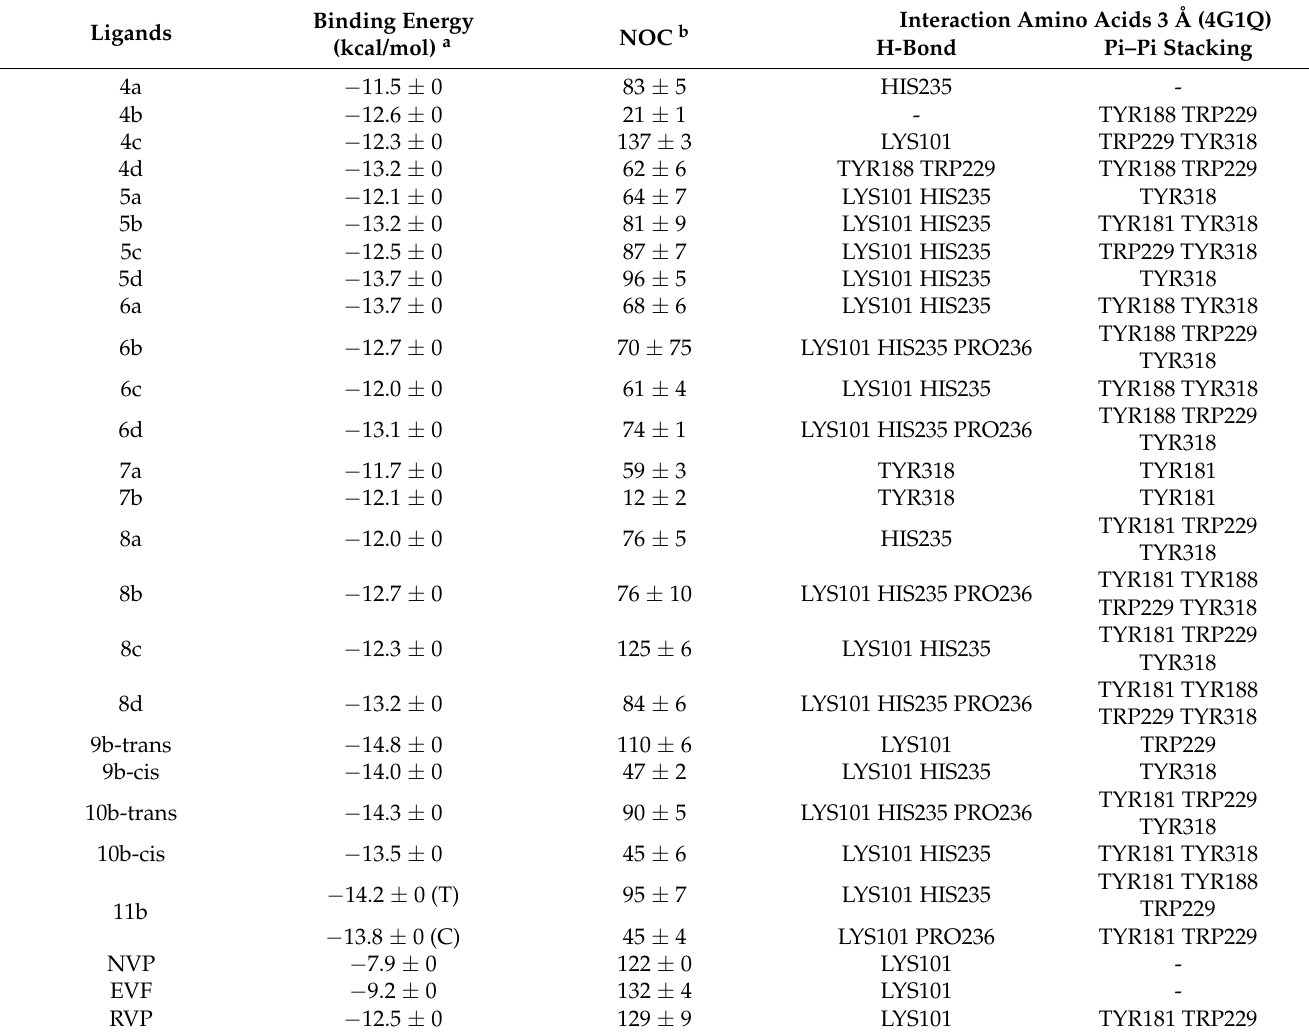
Table 1. Binding energy and interaction of the derivatives and commercially available drugs with HIV-1 RT based on the molecular docking